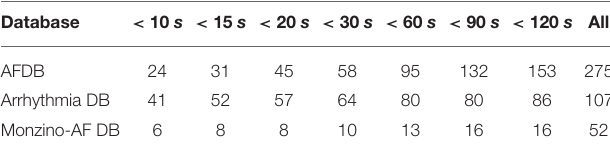
TABLE 7 | Gross duration- and episode-performance on the different testing data bases. AFDB